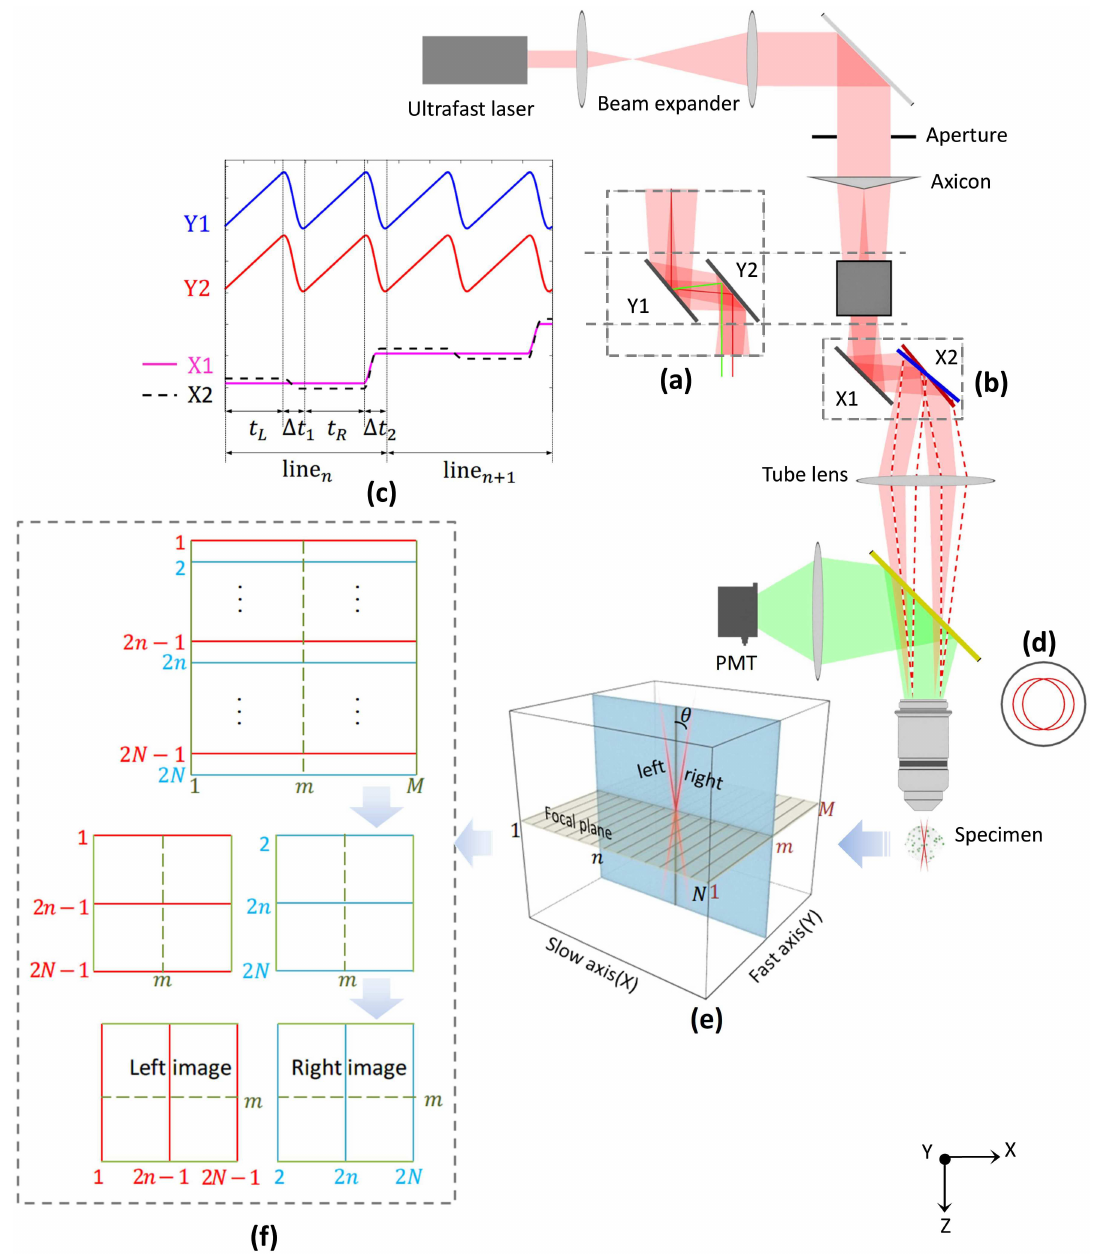
Fig 1. The principle of TPLSSM. (a) Side view of the Y scanningpair. The red and green lines show two parallelscanning positions.(b) The X scanningpair. X2 serves as an angle switcher for tilting the focus. (c) Control waveforms of the Stereo- scanner. (d) Switchable annular illumination at BFP. (e) Stereoscopically scanningwith tilted Bessel beams. Scanning geometry with N × M scanningpositionswith each positionexcited twice from different angles(f) Data processingof interlaced raw images. From top row to bottom row: Interlaced raw data with odd and even lines for left (red) and right (cyan) views, respectively;Deinterlaced into two matrices; Rotated 90˚ and to create a stereo-pair. The acquiredstereo-pair can be directly viewedwith 3D glasses or processedby correspondence algorithmfor depth